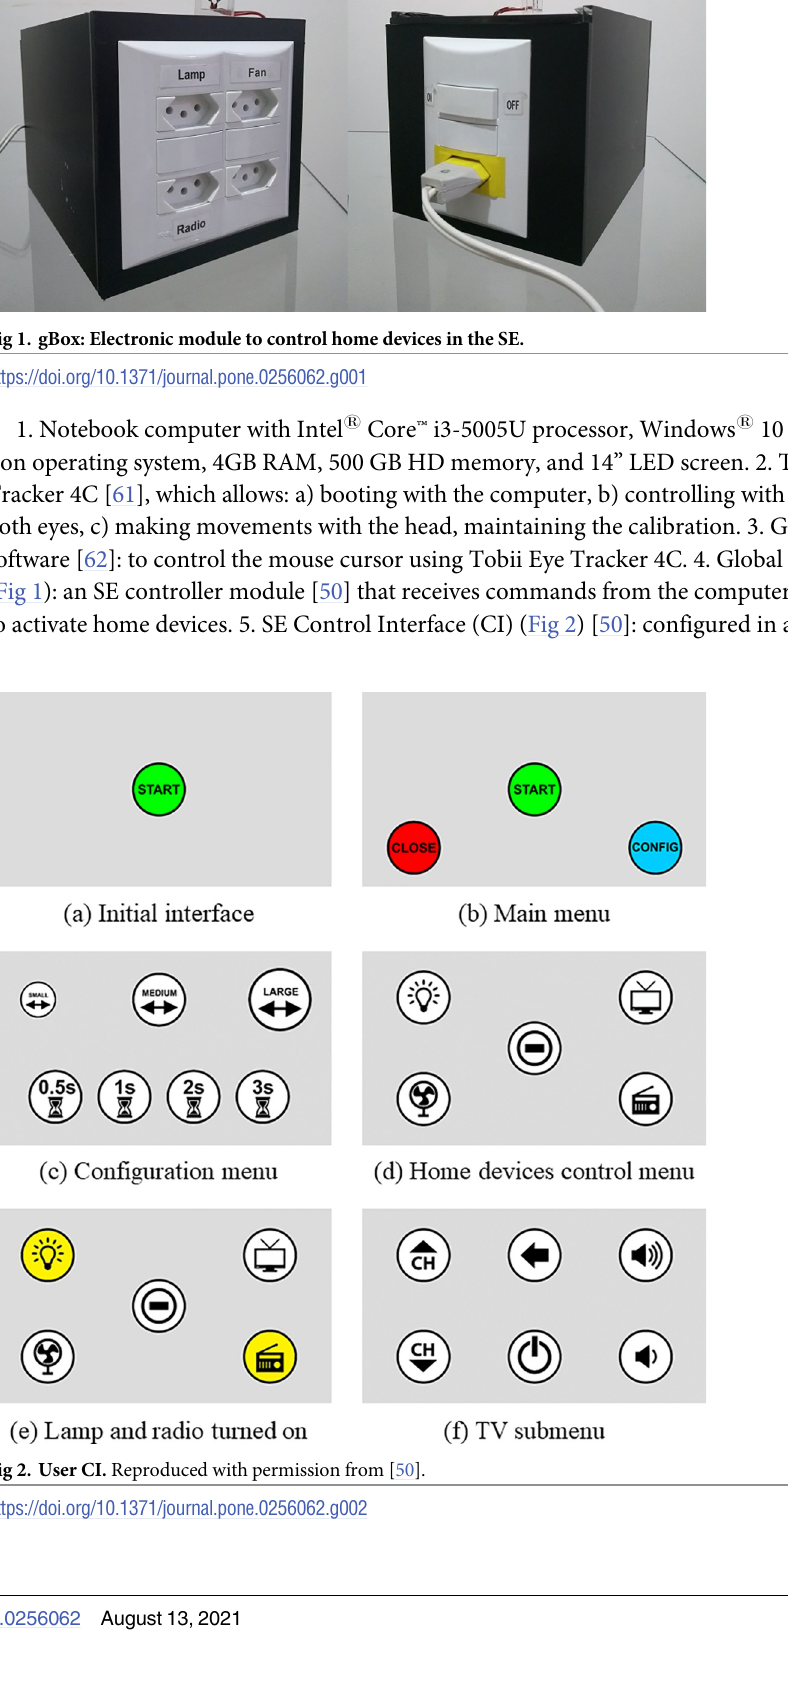
Fig 2. User CI. Reproduced with permission from